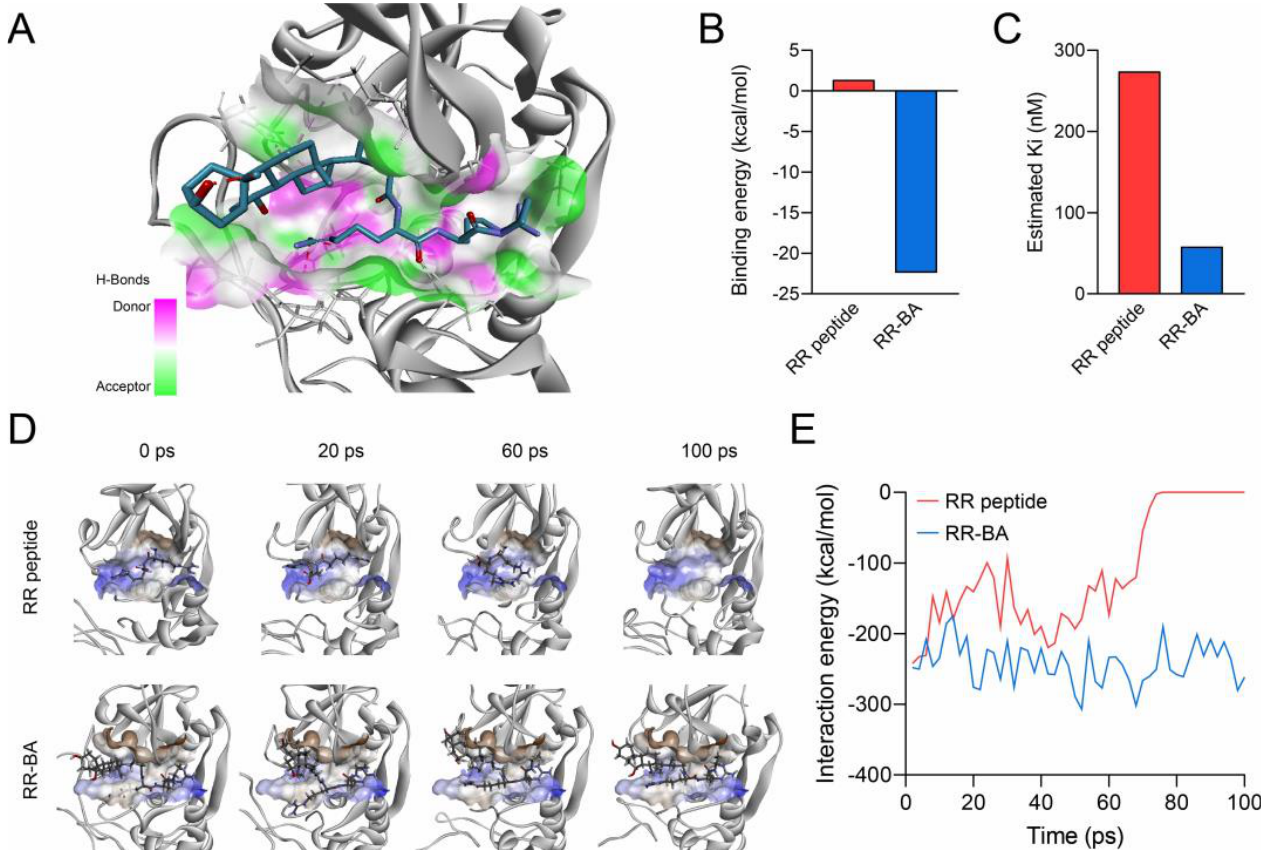
Figure 4. ( A ) Interactions of the docked RR–BA molecule with amino acid residues of cathepsin B. ( B ) Calculated binding energy of RR–BA and RR peptide in docked conformation. ( C ) Estimated